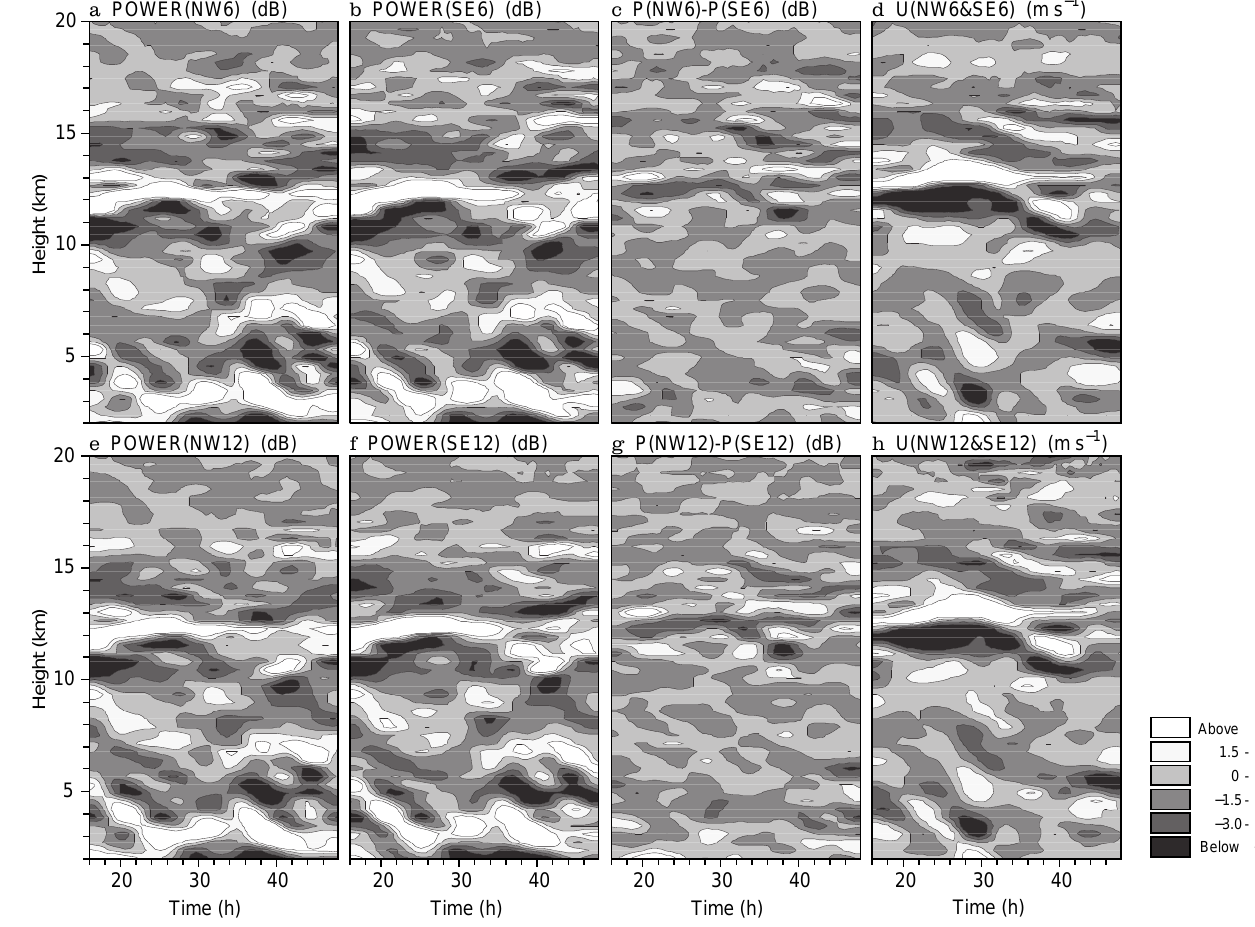
Fig. 2a–h. As Fig. 1, for the dataset 13–14 April 1996. The tropopause is near 11–12 km echo power between 0 (cid:14) and 12 (cid:14) beams is approximately 7 dB for the lower case and 25 dB for the upper; i.e. the wind shear seems to be associated with large power di(cid:128)erences only when aspect sensitivity is strong.